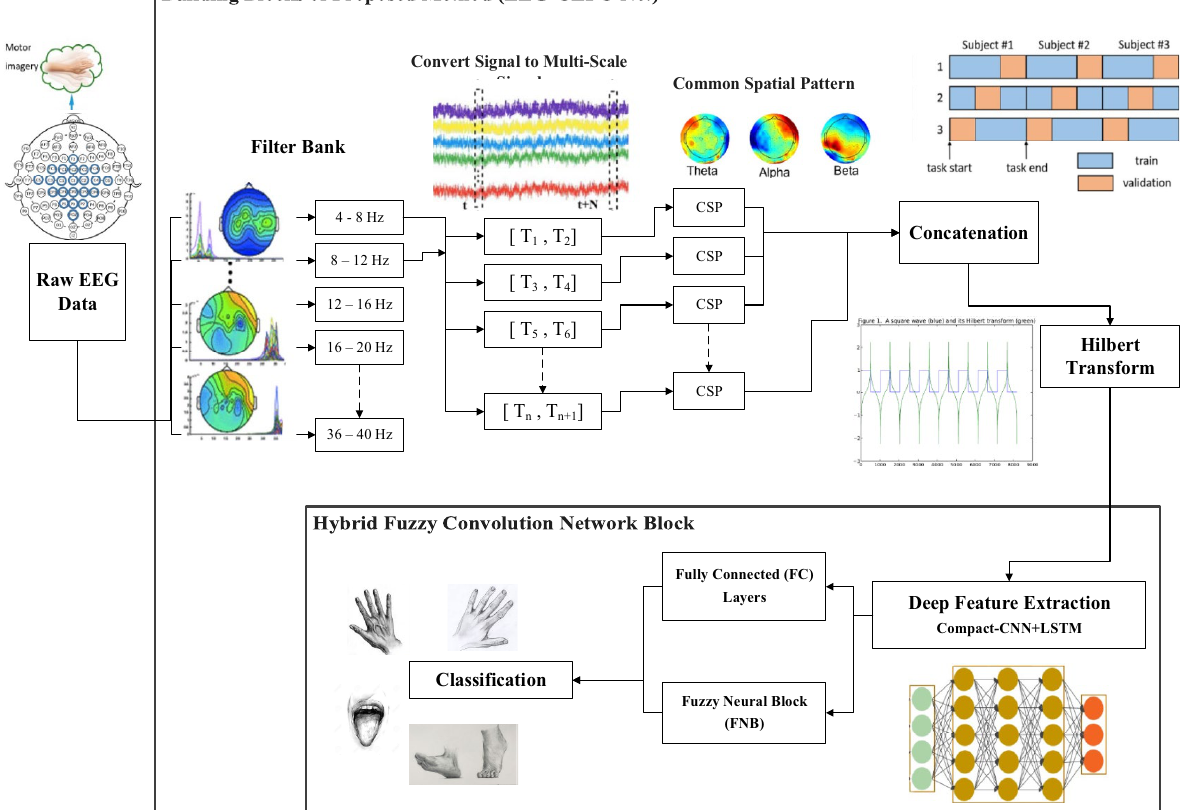
Figure 2. Building blocks of proposed work, Deep Frequency Band Convolutional Neural